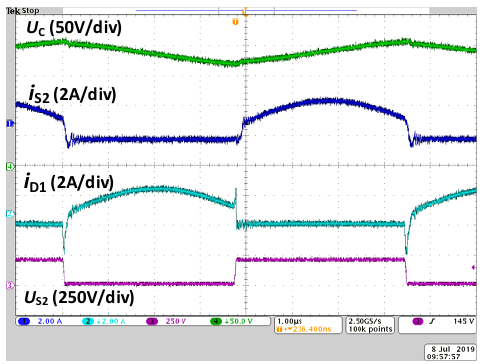
Figure 12. CCM operation of SCVD in steady-state in ZVS and nearly ZCS mode. Waveforms of voltage on switched capacitor C , current of transistor S 2, current of diode D 1, voltage on transistor S 2. U in = 200 V, f S = 201.6 kHz, P out = 400 W. Switching pattern P2.